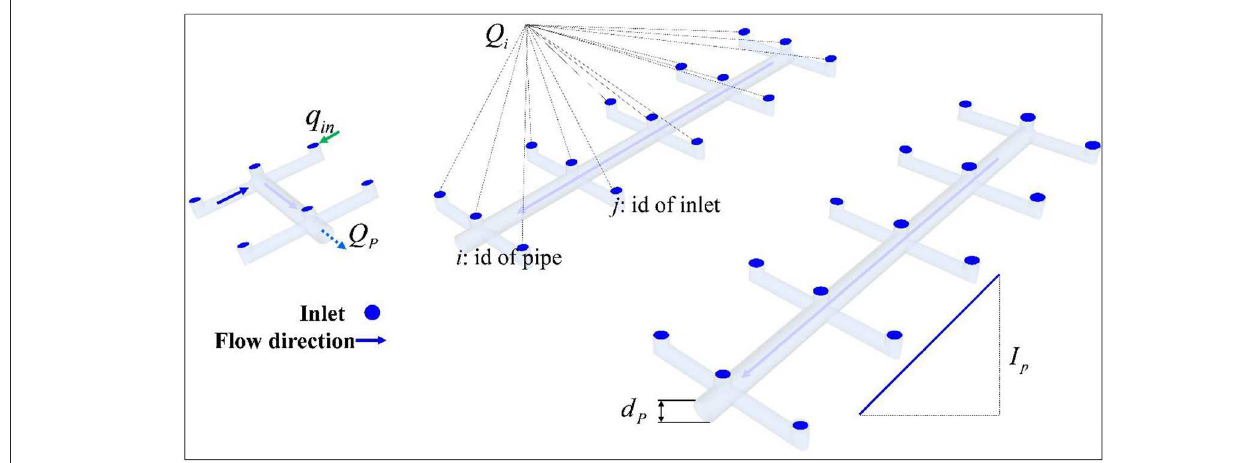
FIGURE 3 | Symbol diagram of the new approach.